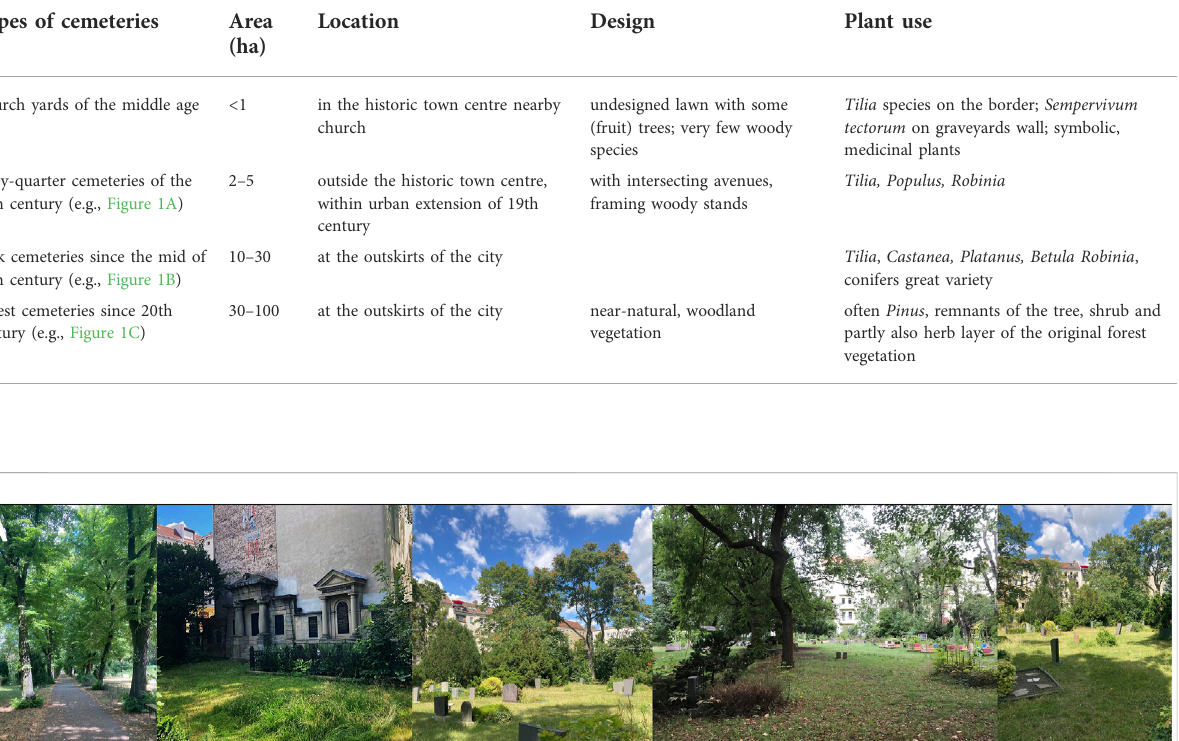
TABLE 3 Overview of types of cemeteries in Central Europe adapted from Graf (1986), Sörries (2003).